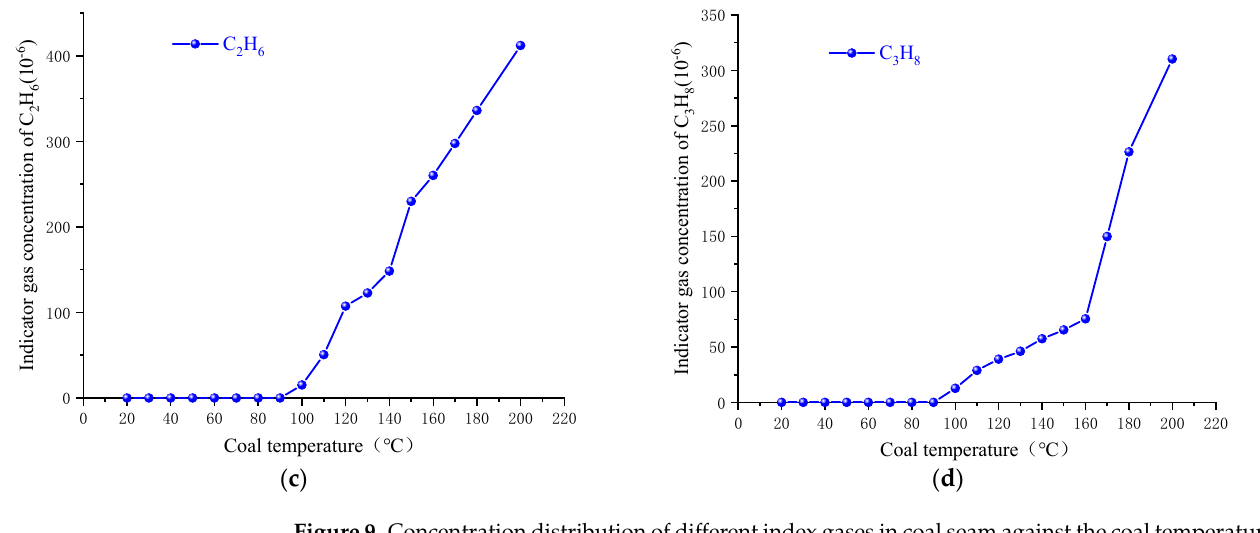
Figure 9. Concentration distribution of different index gases in coal seam against the coal temperature. ( a ) CO and CO 2 , ( b ) C 2 H 4 , ( c ) C 2 H 6 , ( d ) C 3 H 8 .